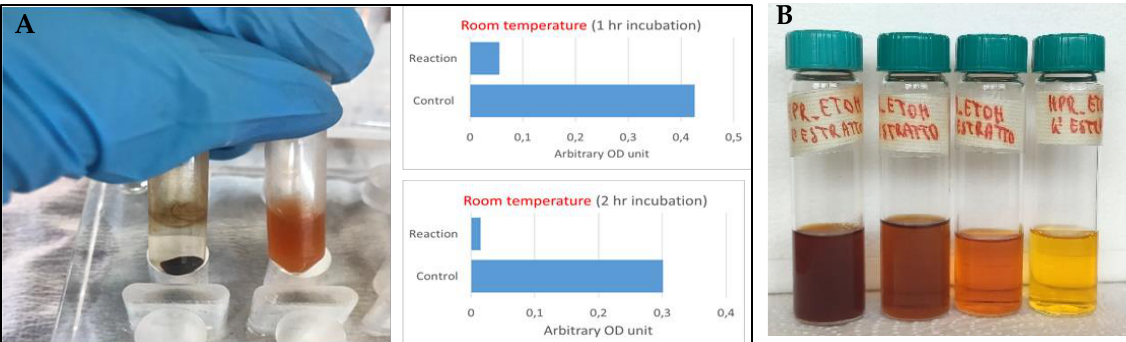
Figure 4. ( A ) Effect of incubation time (1 & 2 h) at room temperature and 250 µg of magnetic nanoparticles on recovery of carotenoids from H. pluvialis extracts prepared using CO 2 supercritical fluid extraction and ethanol as solvent. Spectrophotometric data are presented using arbitrary units to indicate solution absorbance (also known as Optical Density, OD). Charts on the left report the OD of control and reaction samples (supernatant). ( B ) Carotenoid solutions resulting from multistep CO 2 supercritical fluid extraction of H. pluvialis biomass.